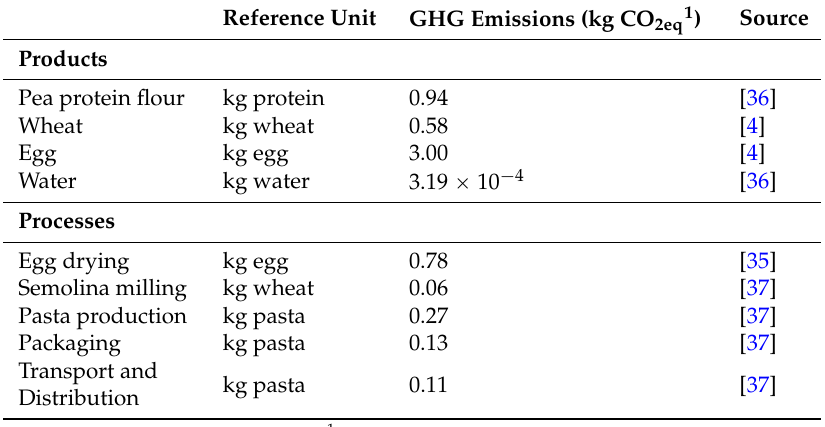
Table 1. Relevant greenhouse gas (GHG) emission fluxes for the products and processes of the considered value